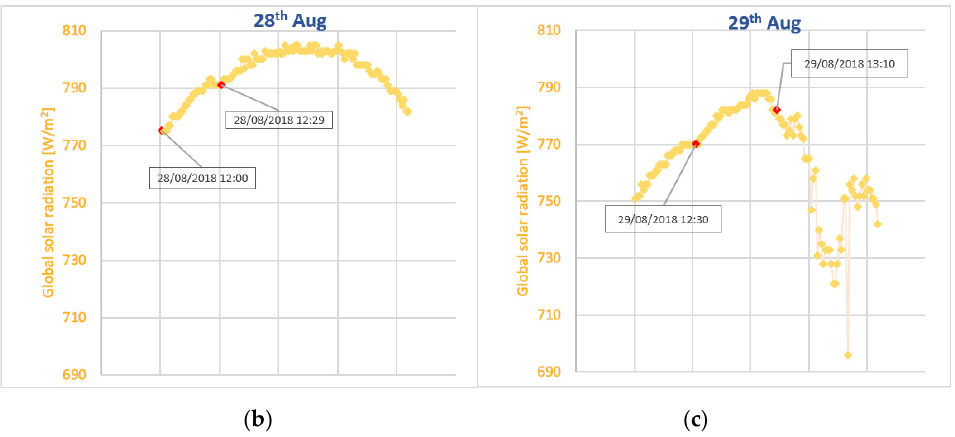
Figure 11. ( a ) Global solar radiation (left axis), outdoor temperature and relative humidity (right axis) recorded during the experimental campaigns. Red dots on the global solar radiation plot mark the start and end of the two thermographic campaigns; ( b ) global solar radiation between 12:00 a.m. and 2 p.m. of 28th August; ( c ) global solar radiation between 12:00 a.m. and 2 p.m. of 29th August.